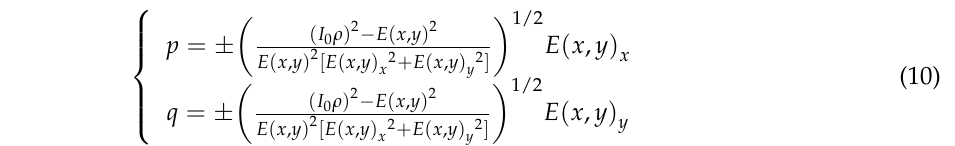
curveQuantized gray curve Smoothed gray